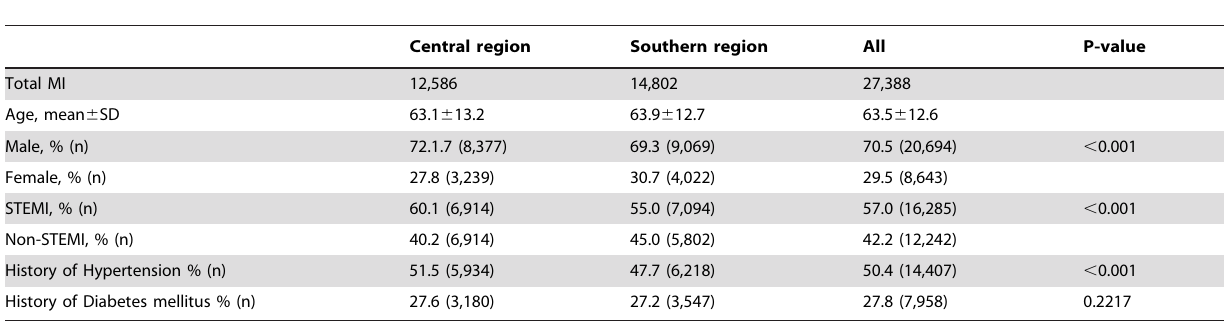
Table 1. General Characteristics of the Study